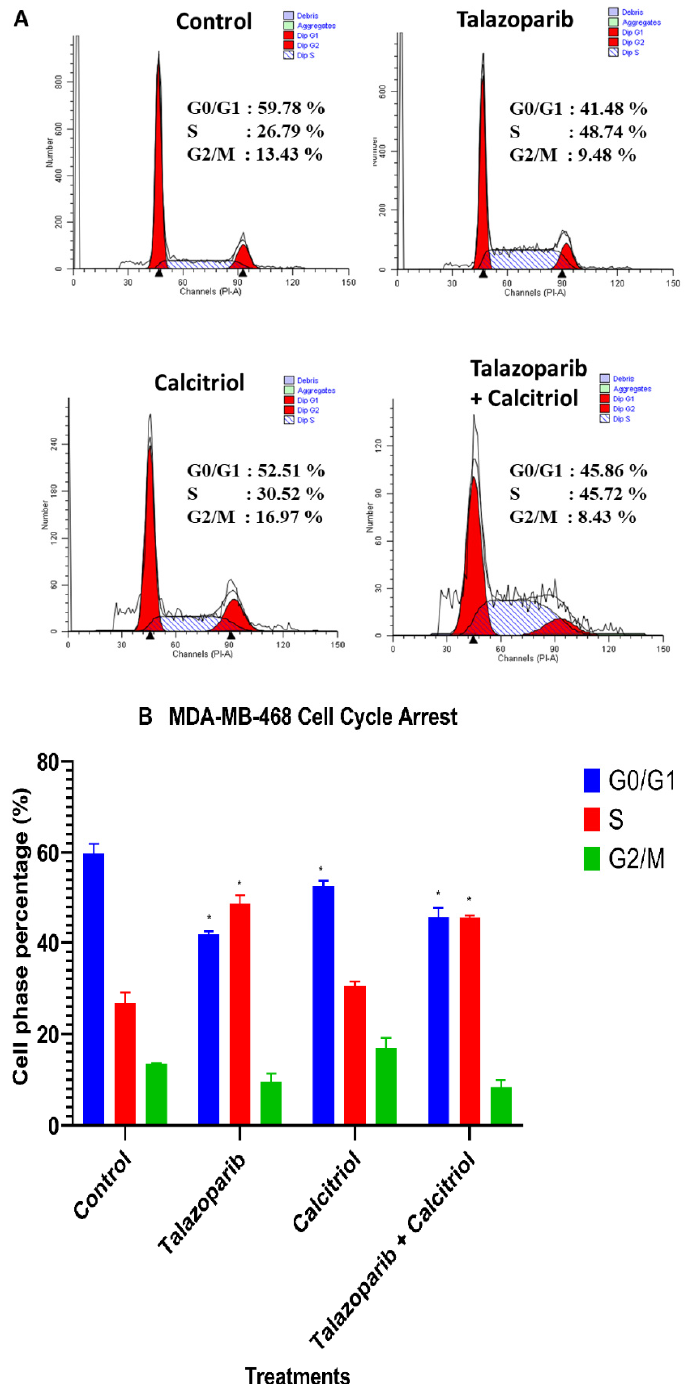
Figure 12. Effect of talazoparib and calcitriol on cell cycle progression in MDA − MB − 468 cells. ( A ) FACS analysis (Results are representative of three independent experiments). ( B ) Analysis of the cell cycle with talazoparib, calcitriol and combined treatment. MDA − MB − 468 was treated with 1 mM talazoparib and 10 µM calcitriol for 24 h. Compared to the untreated cells, an increase in the population of S phase cells was observed, whereas the population of cells in G0/G1 phase decreased. The results represent the mean ± SD of three independent experiments. * p < 0.05 vs. control. Data were compared between the untreated control and the treatment groups by a one − way ANOVA post − hoc test (Tukey) using SPSS. Raw data and details of statistical analysis can be found in Supplementary File S10 and Table S6,